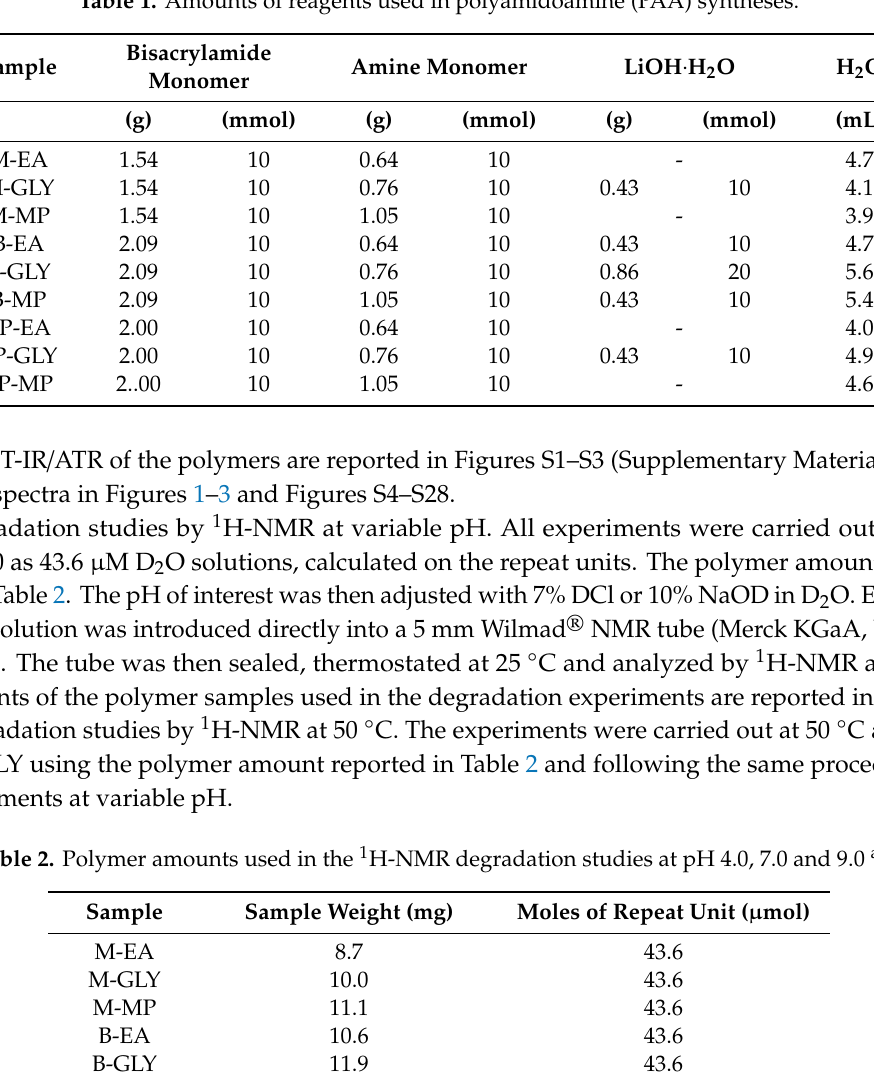
Table 1. Amounts of reagents used in polyamidoamine (PAA) syntheses.